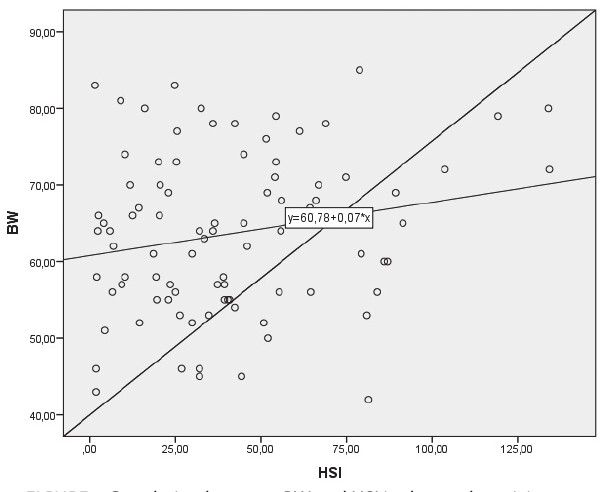
FIGURE 1 Correlation between BW and HSI in the total participants